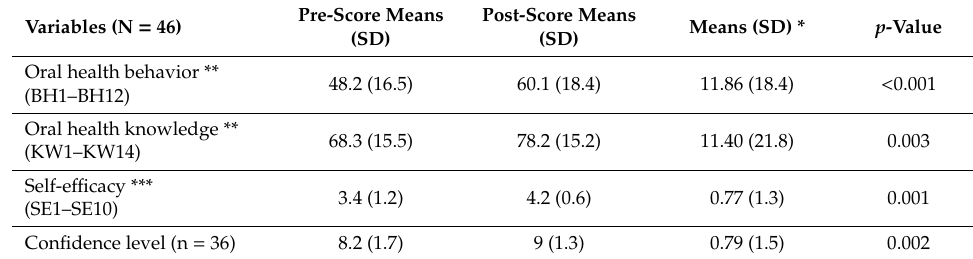
Table 1. Di ff erence in the pre- and post-oral health prevention intervention overall means. Pre-Score Means Variables (N = 46)